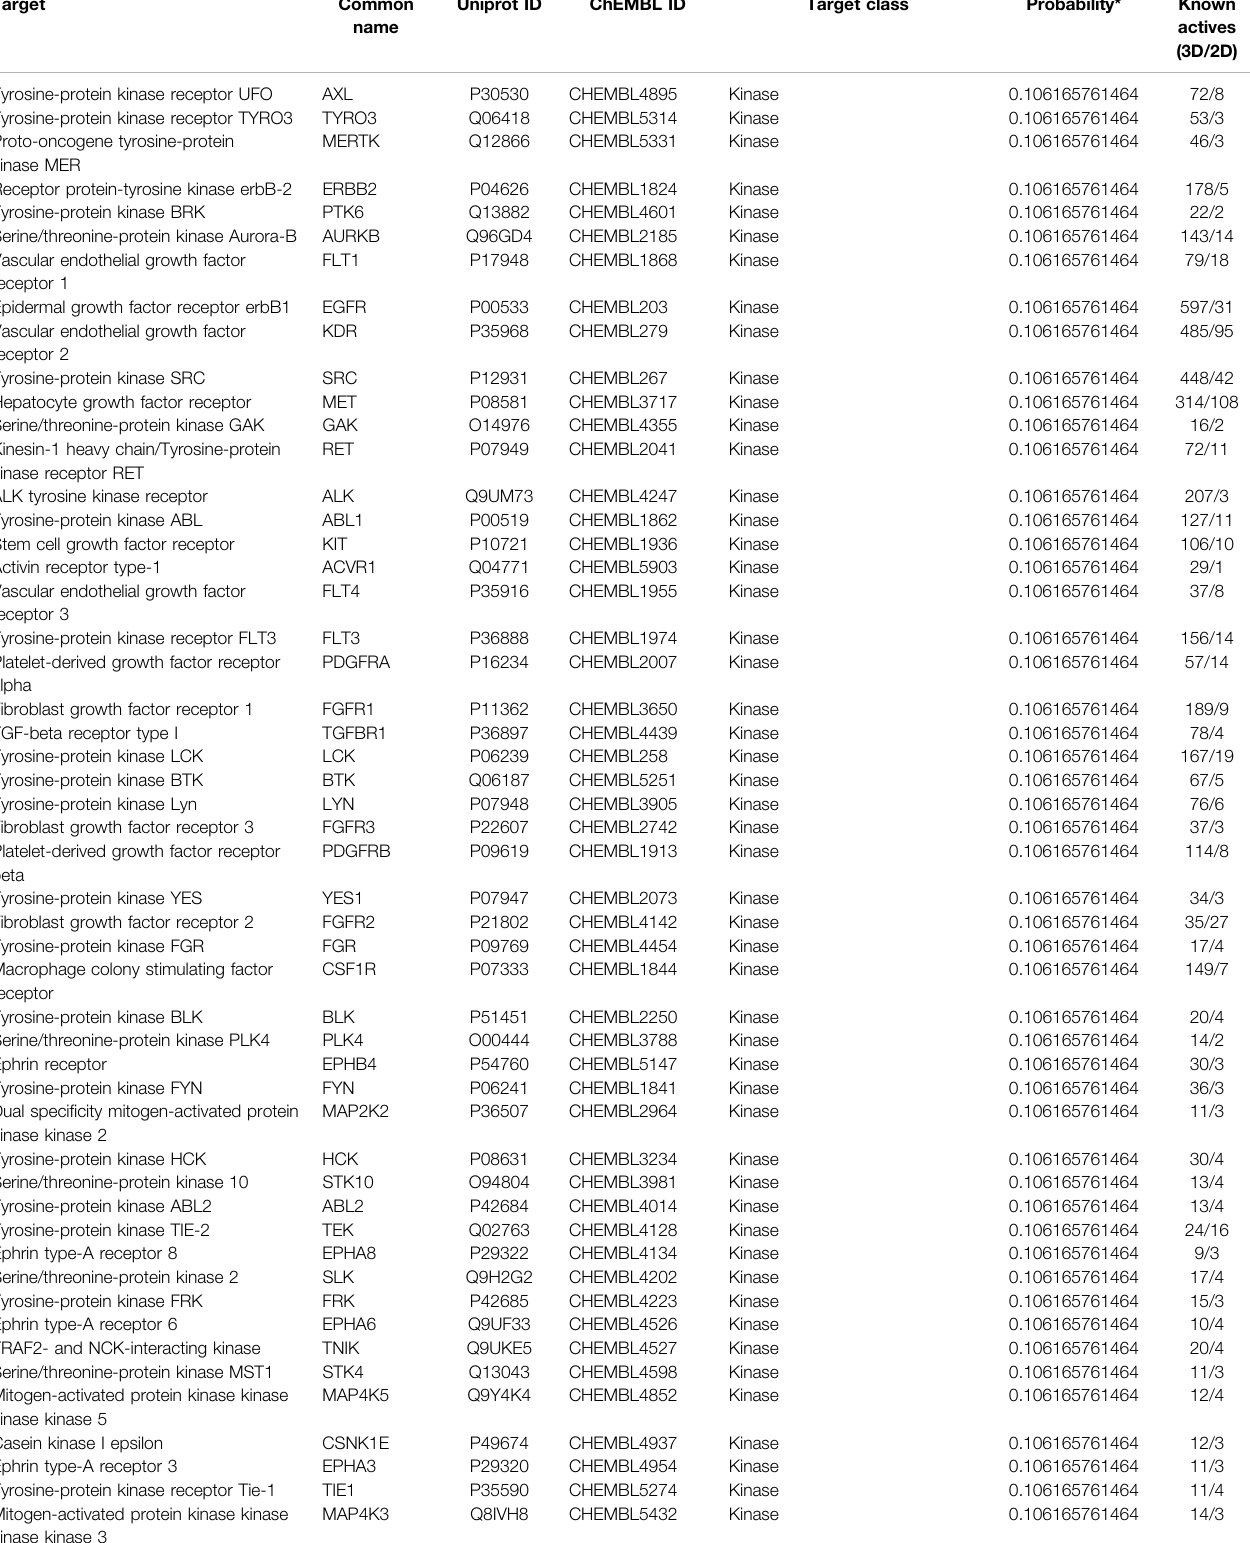
TABLE 2 | Targets of anlotinib obtained through